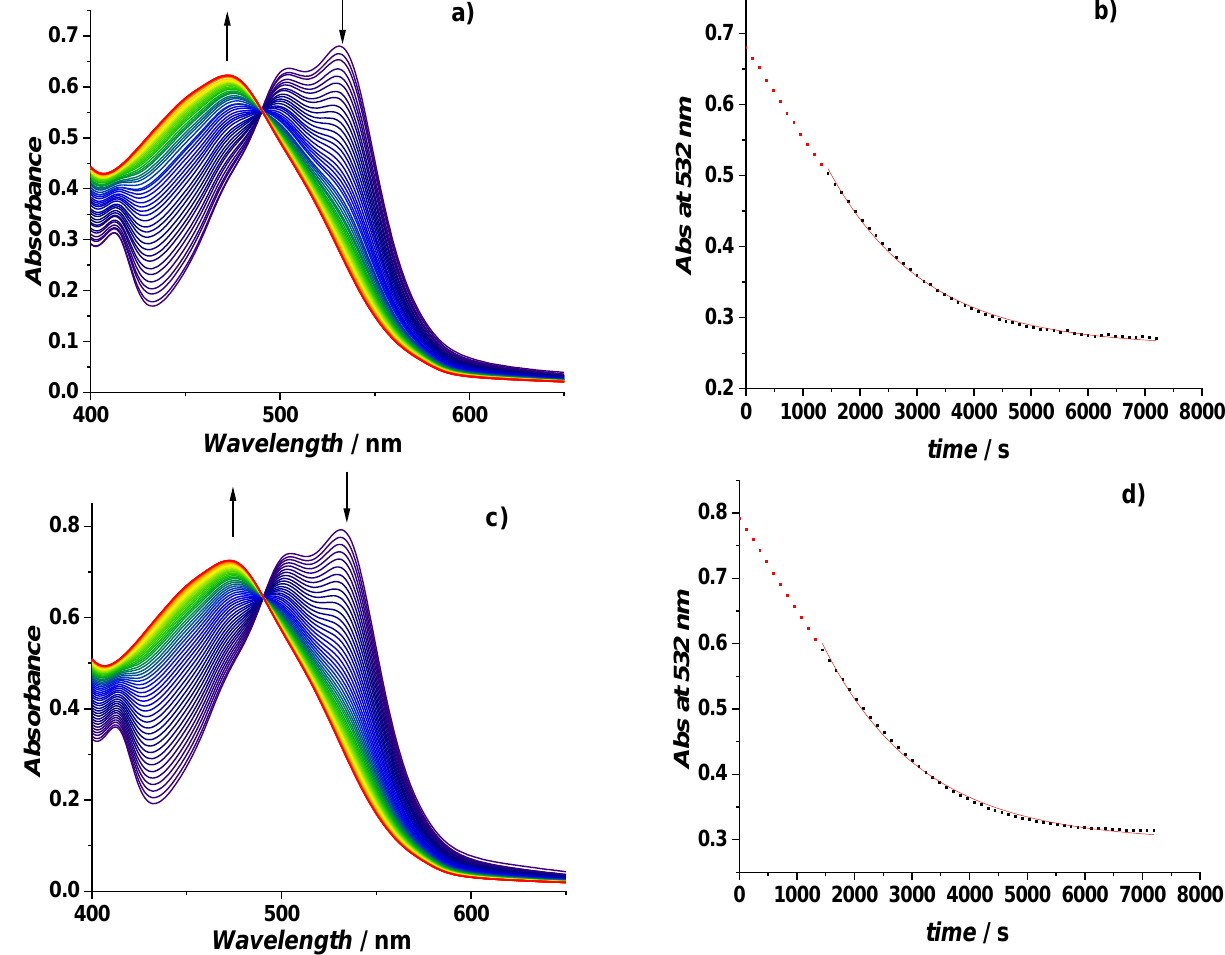
Figure 4. UV-Vis spectral changes recorded for the reaction between CblNO 2 (8.6 × 10 −5 M) and Asc (1.7 × 10 −3 M) at pH 4.3 (25.0 °C, acetate buffer) during the formation of CblNO in the presence of winter ( a ) and summer ( c ) Krakow dust, respectively. ( b , d ) fits of absorbance at 532 nm versus time to a first-order rate equation for winter ( b , d ) summer Krakow dust, respectively. The concentration of Krakow winter and summer dust was 0.004 mg/mL.